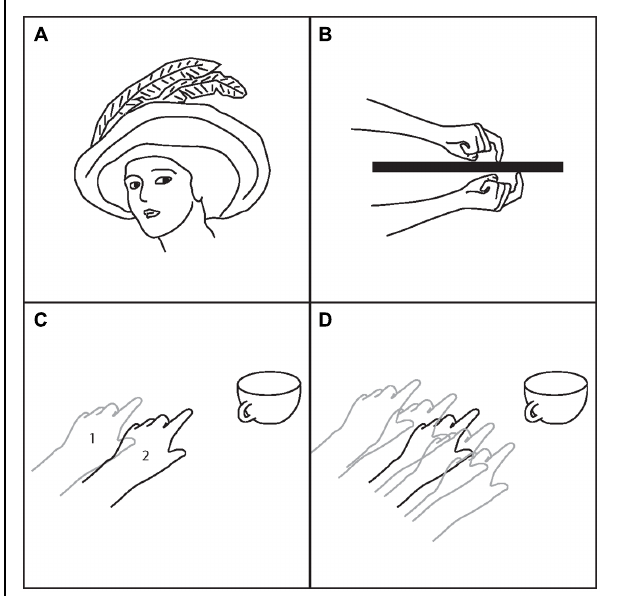
FIGURE 2 | Examples of model-based control. (A) To enter a car without hitting your head requires the body schema to include an accurate model of the shape of your head. Women who wore feathered hats would develop an altered body schema to incorporate the hat, and would avoid hitting the feathers (Head and Holmes, 1911). (B) The body schema depends on visual and somatosensory input, among other sources of information. Somatosensory input, however, is less accurate than visual. If you put your left hand under the table and leave it for a few minutes, the body schema begins to lose a precise representation of arm position. It is then difficult to point with the right hand, on top of the table, to the exact location of the left hand. (C) If the hand is perturbed from point 1 to point 2, but the body schema does not register that change, reaching becomes inaccurate. In this case, the real position is closer to the cup than the position registered by the body schema. The result will be an overreach that may knock over the cup. (D) In some cases the body schema loses specificity. The position of the arm is not precisely represented. In that case maintaining a steady arm position is difficult, especially in the face of external, perturbing forces, and reaching accurately is no longer